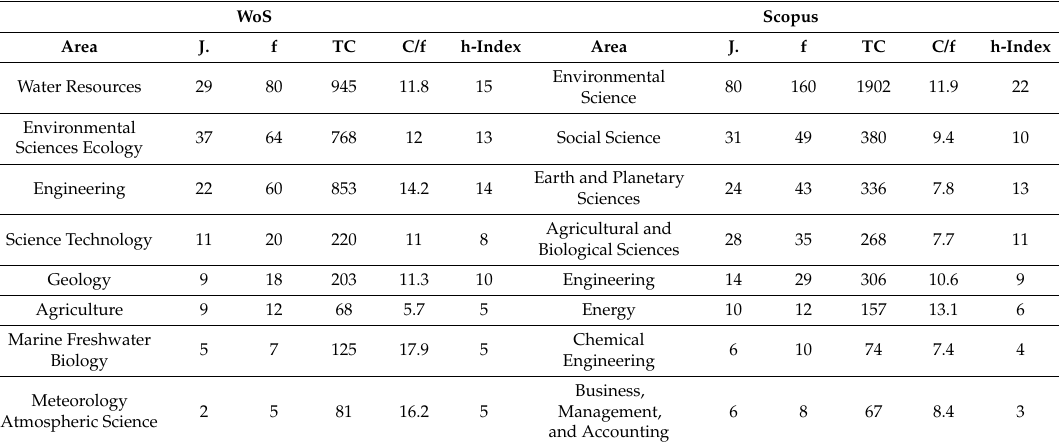
Table 9. Classification of articles by subject